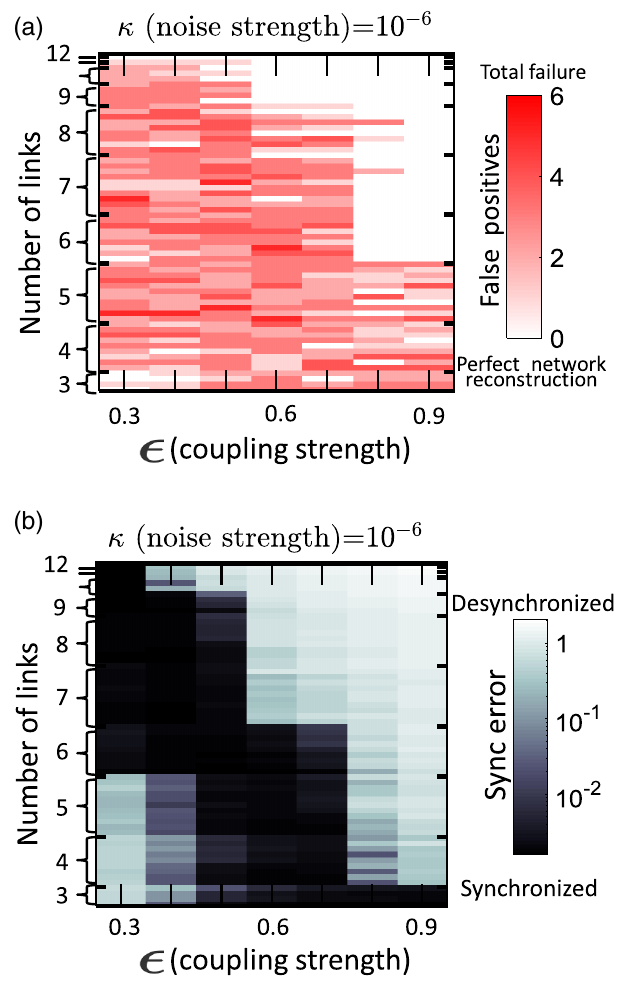
FIG. 7. Simulation test results with varying coupling strength ϵ . (a) Number of false positives and (b) synchronization error for simulated time series from different networks with progressively increasing coupling strength. As described in the text, each horizontal cut of the plots represents a single trajectory of the system, starting from a random initial condition. The convention for sequence of the networks is the same as in Fig.